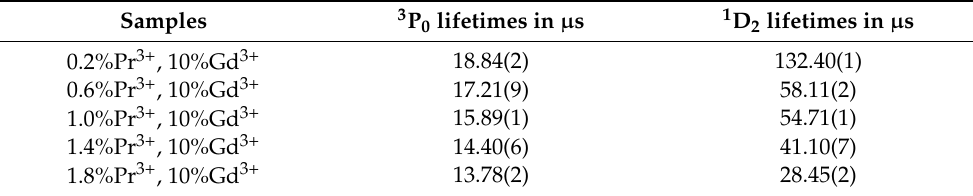
Table 2. The calculated lifetimes for 3 P 0 decay and 1 D 2 decay. Samples